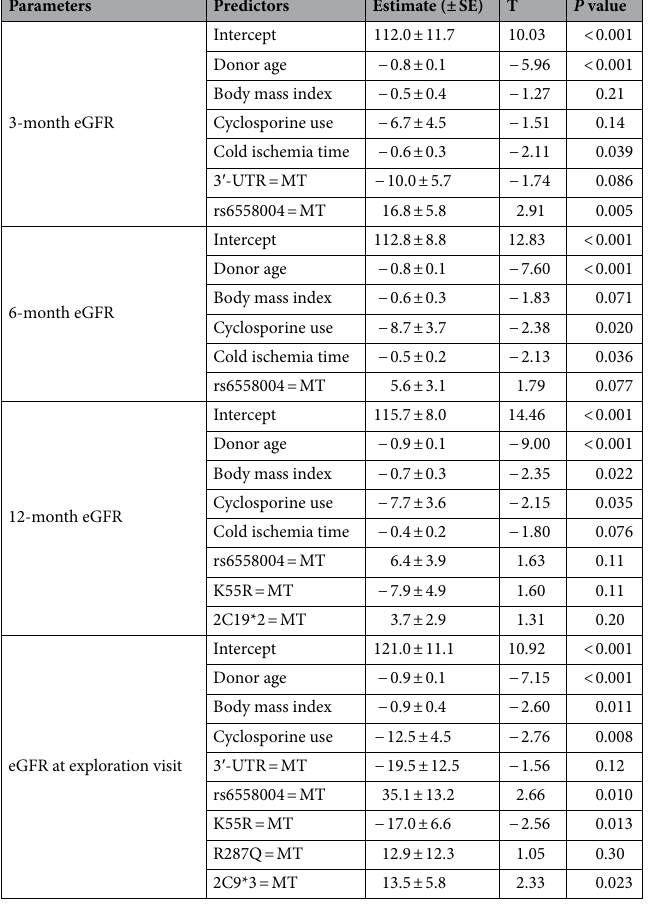
Table 2. Multiple linear regression of estimated glomerular filtration rate (eGFR) according to the predictors obtained from leaps